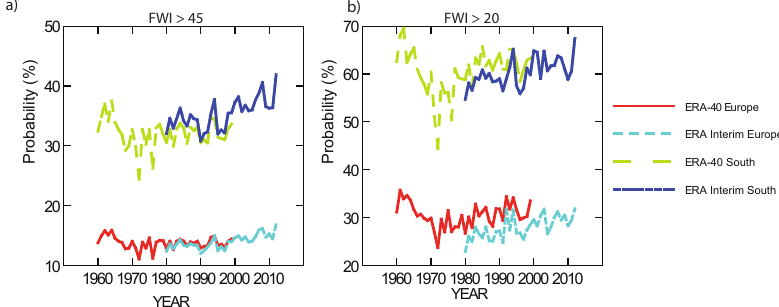
Figure 4. The year-to-year variation of March–September FWI values above 20 and above 45 from ERA-40 and ERA Interim data sets calculated for southern Europe and for the whole of Europe. The value is expressed as a probability (Eq.